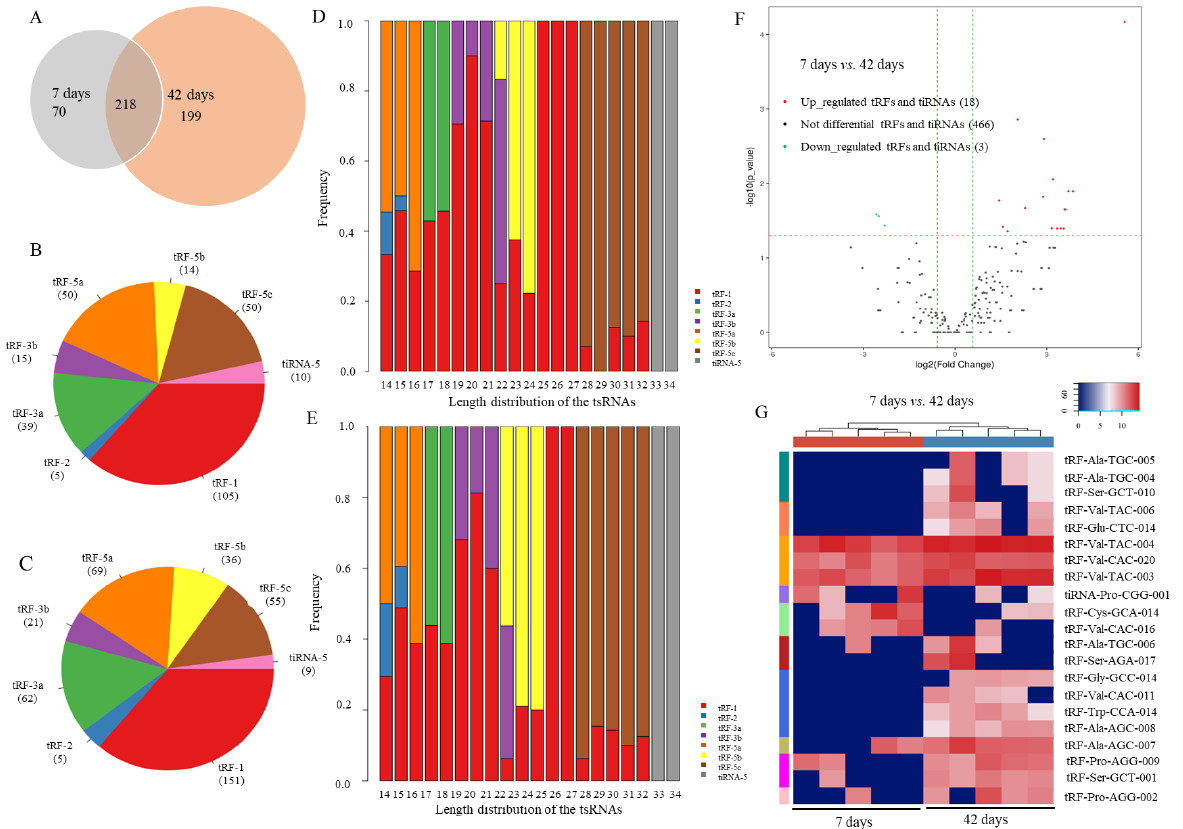
Figure 1. Expression pattern of tsRNAs in Drosophila at 7 days and 42 days. ( A ) newly discovered and known tsRNAs; ( B ) classification of tsRNAs at 7 days; ( C ) classification of tsRNAs at 42 days; ( D ) subtype length of tsRNAs at 7 days; ( E ) subtype length of tsRNAs at 42 days; ( F ) significantly up/downregulated tsRNAs between 7 days and 42 days; ( G ) heatmap of 21 differentially expressed tsRNAs.